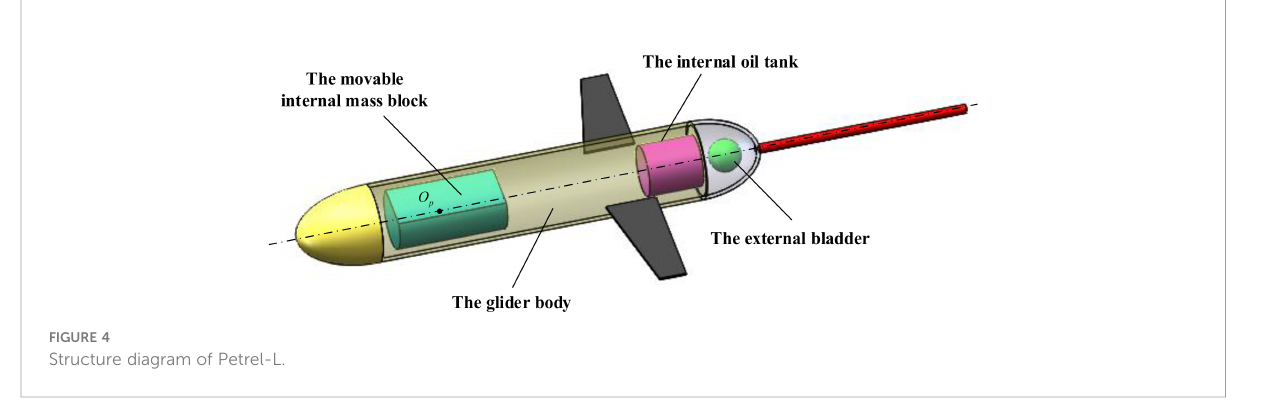
FIGURE 4 Structure diagram of Petrel-L.